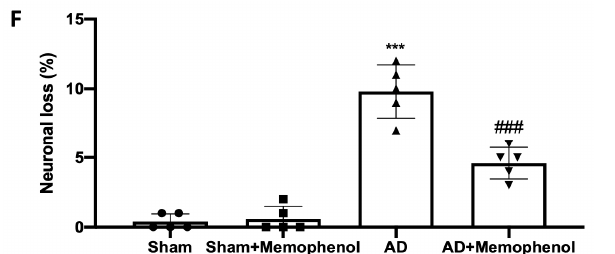
Figure 1. The administration of Memophenol TM reduced behavioral and hippocampal alterations. MWM test: training ( A ); probe trial ( B ); EPM test ( C ); NOR test ( D ); histological analysis: Sham, Sham + Memophenol, AD, AD + Memophenol ( E ); quanti fi cation of necrotic neurons ( F ). Scale bar 75 µm. For the behavioral and histological investigations, n = 5 rats were used from each group and for each analysis. A p -value less than 0.05 was regarded as signi fi cant. *** p < 0.001 versus Sham, ### p < 0.001 versus AD.